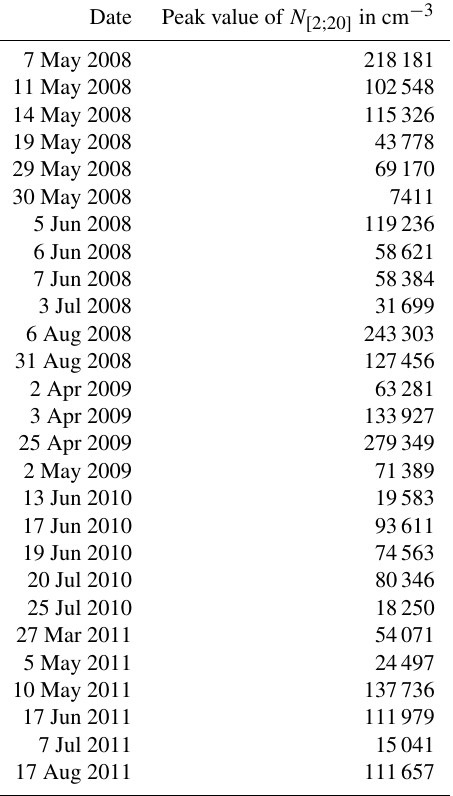
Table C1. List of 27 manually selected NPF event days whose av- erage diurnal profiles of N [2;20] served as a reference function f (t) in Eq. (3). This list encompasses NPF events that showed clear pat- terns of particle nucleation and subsequent growth in terms of par- ticle number size